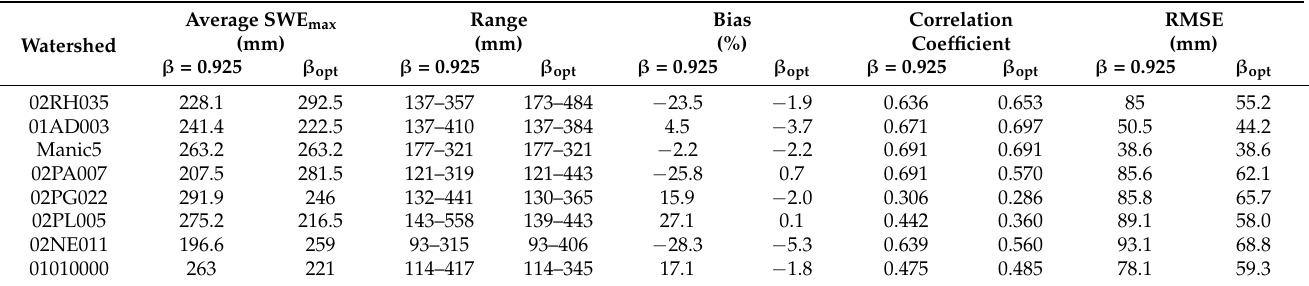
Table 6. Performance metrics of the WSC approach using the recommended β and the optimized β for the